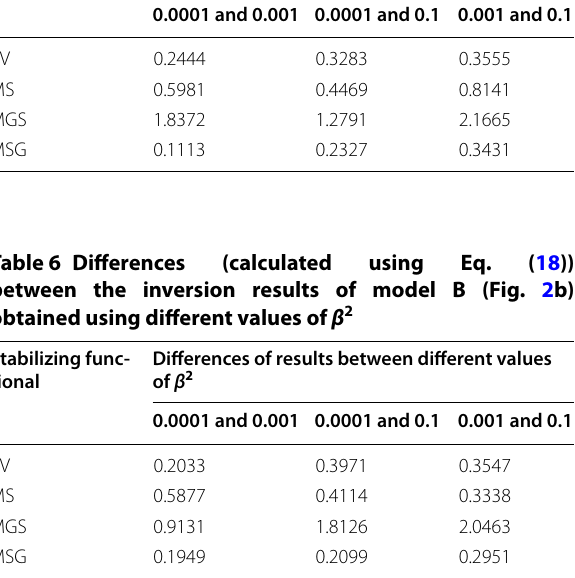
Table 5 Differences [calculated using Eq. (18)] between the inversion results of model A (Fig. 2a) obtained using different values of β 2 Stabilizing func‑ Differences of results between different values tional of β 2